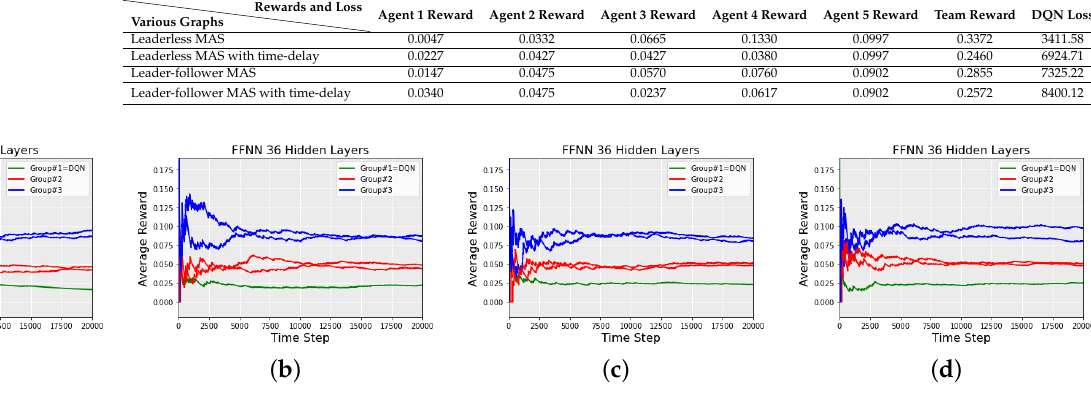
Table 1. Comparison of each agent’s average reward and DQN loss of a heterogeneous MAS, including N = 5 agents in P = 3 different clusters, during 20,000 time steps without considering the distance-based reward.